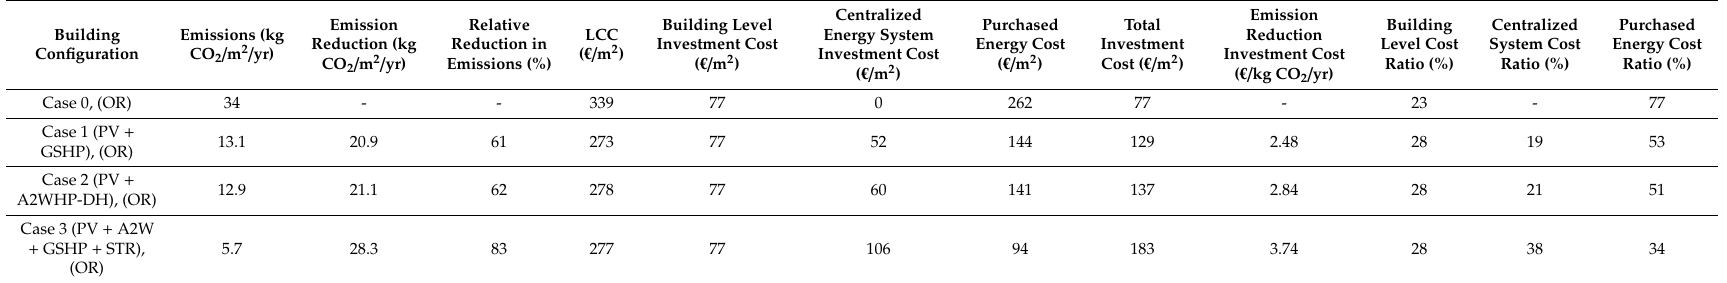
Table 4. Emissions and cost comparison of the proposed centralized community-level energy district heating systems (Cases 1, 2, and 3) integrated with the original reference (OR) old residential buildings in the district and reference city-level district heating system (Case 0).